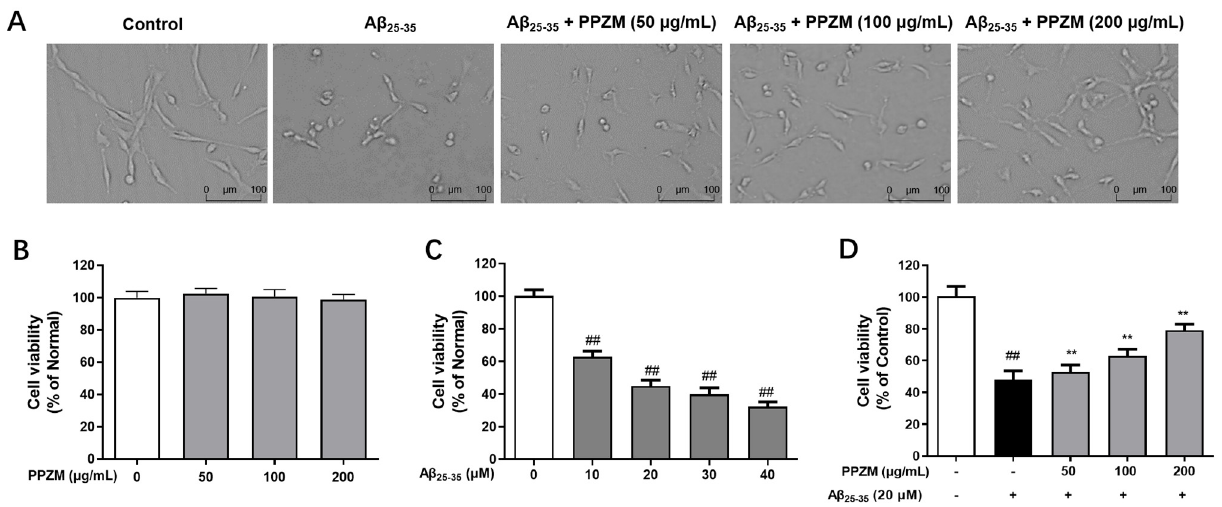
Figure 2. Neuroprotective effects of PPZM on A β 25–25 -induced neurotoxicity. ( A ) Cell morphology observed under a light microscope (the scale bar was 100 µ m). ( B ) The effects of PPZM on the cell viability of normal PC12 cells. ( C ) The neurotoxicity of A β 25–25 on PC12 cells. ( D ) The protective effects of PPZM on A β 25–25 injured PC12 cells. Cell viability was measured by MTT. Results are presented as the mean ± SD. ## p < 0.01 vs. the control group; ** p < 0.01 vs. the A β 25–25 treated group.